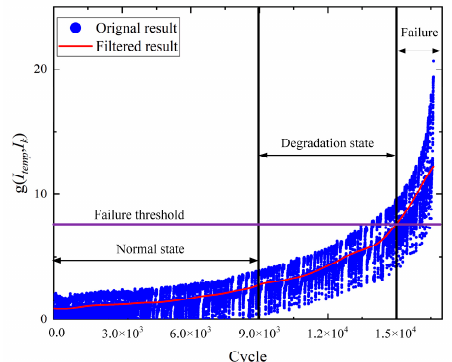
Figure 7. Current signal.